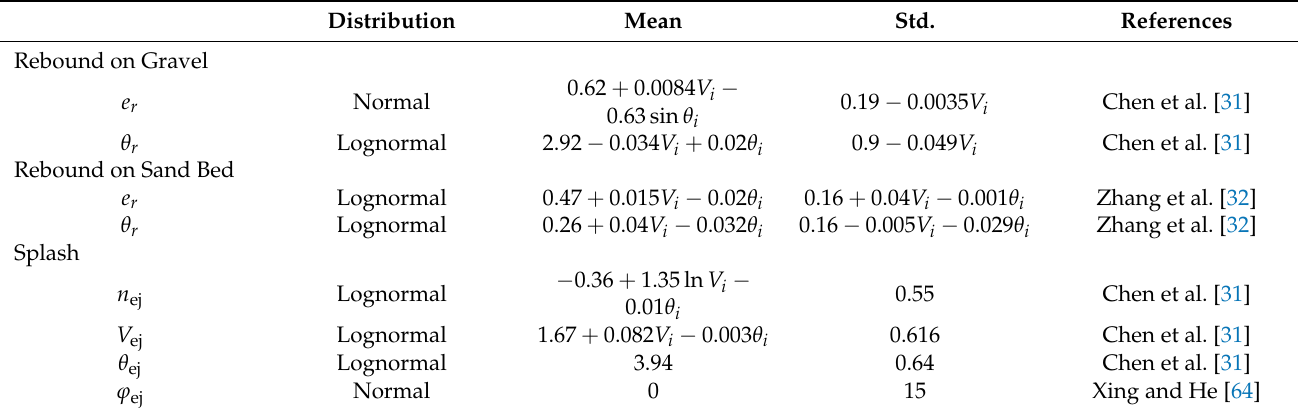
Table 1. Parameters of the Splash